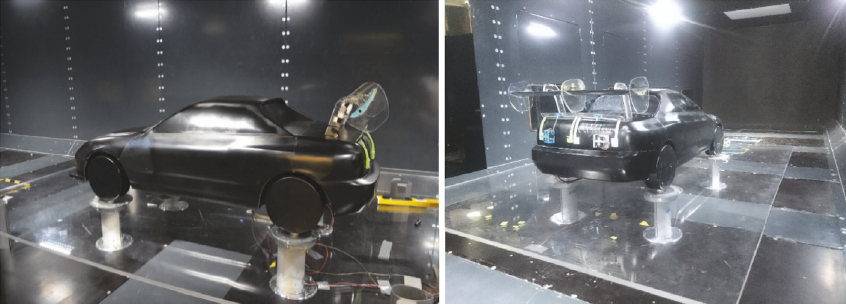
Figure 5: Model of the vehicle in the wind tunnel.